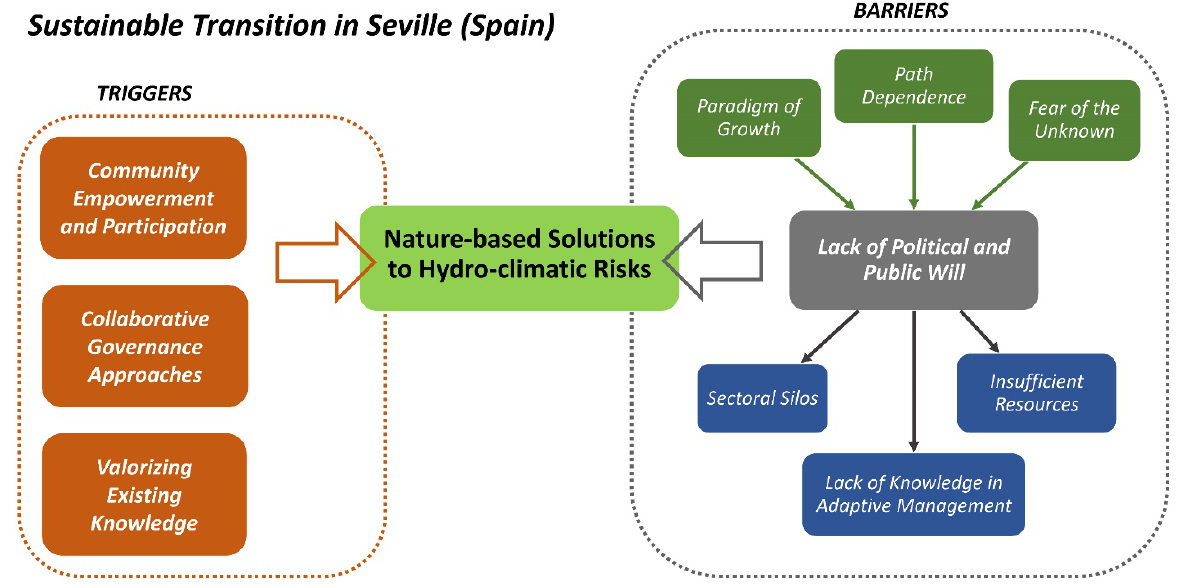
Figure 4. NbS to HCR. Synthesis of triggers and barriers to community and institutional responses in Seville. Source: author’s elaboration.